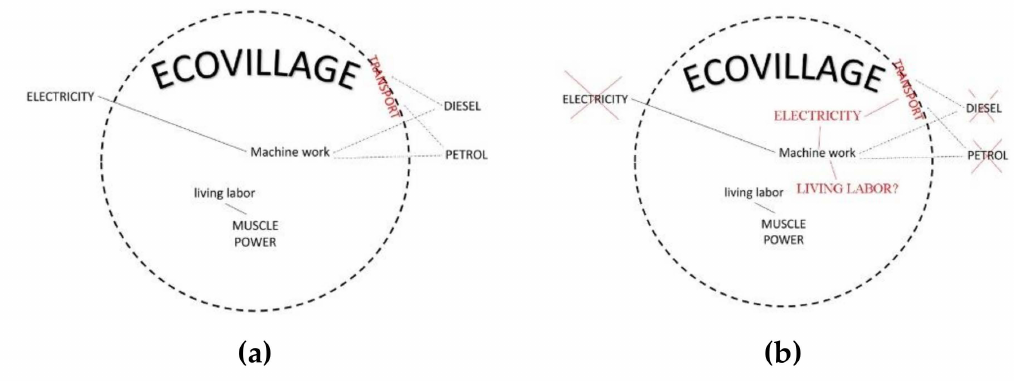
Figure 12. Space structure of energy system of agriculture and forestry in Visnyesz é plak ( a ) present ( b )